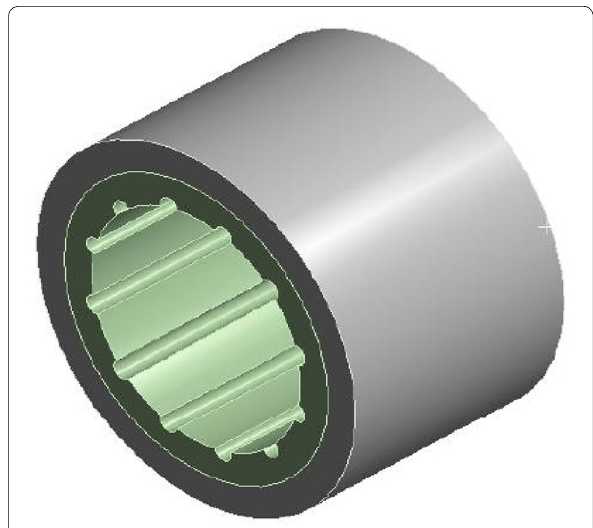
Figure 1 Normal water-lubricated